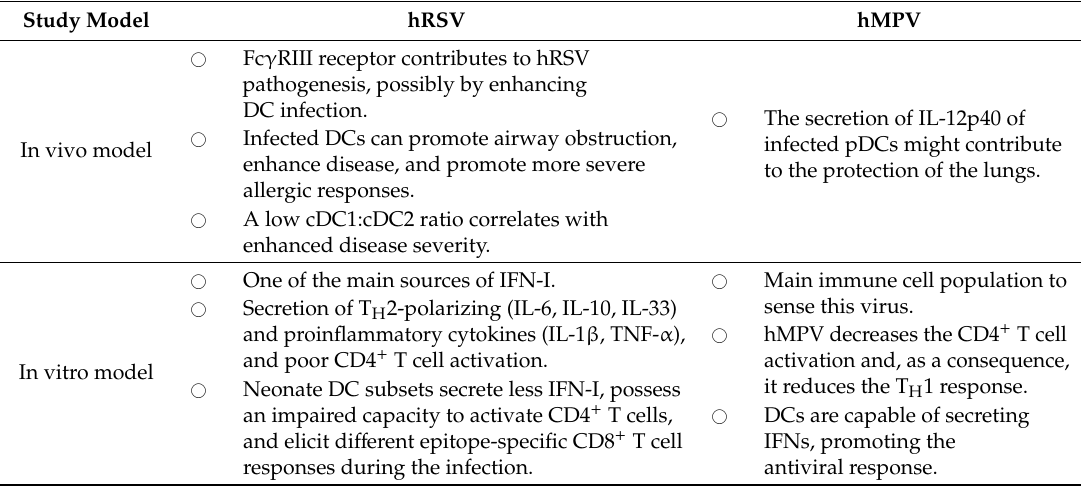
Table 1. Role of DCs in the pathology caused by hRSV and